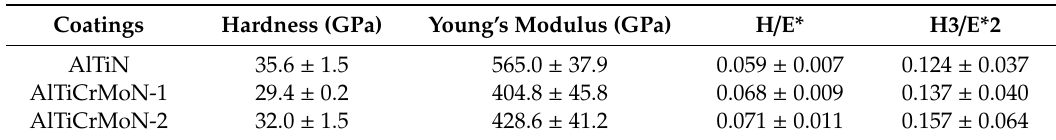
Table 3. Hardness, Young’s modulus, H / E* and H 3 / E* 2 value of the deposited AlTiN, AlTiCrMoN-1 and AlTiCrMoN-2